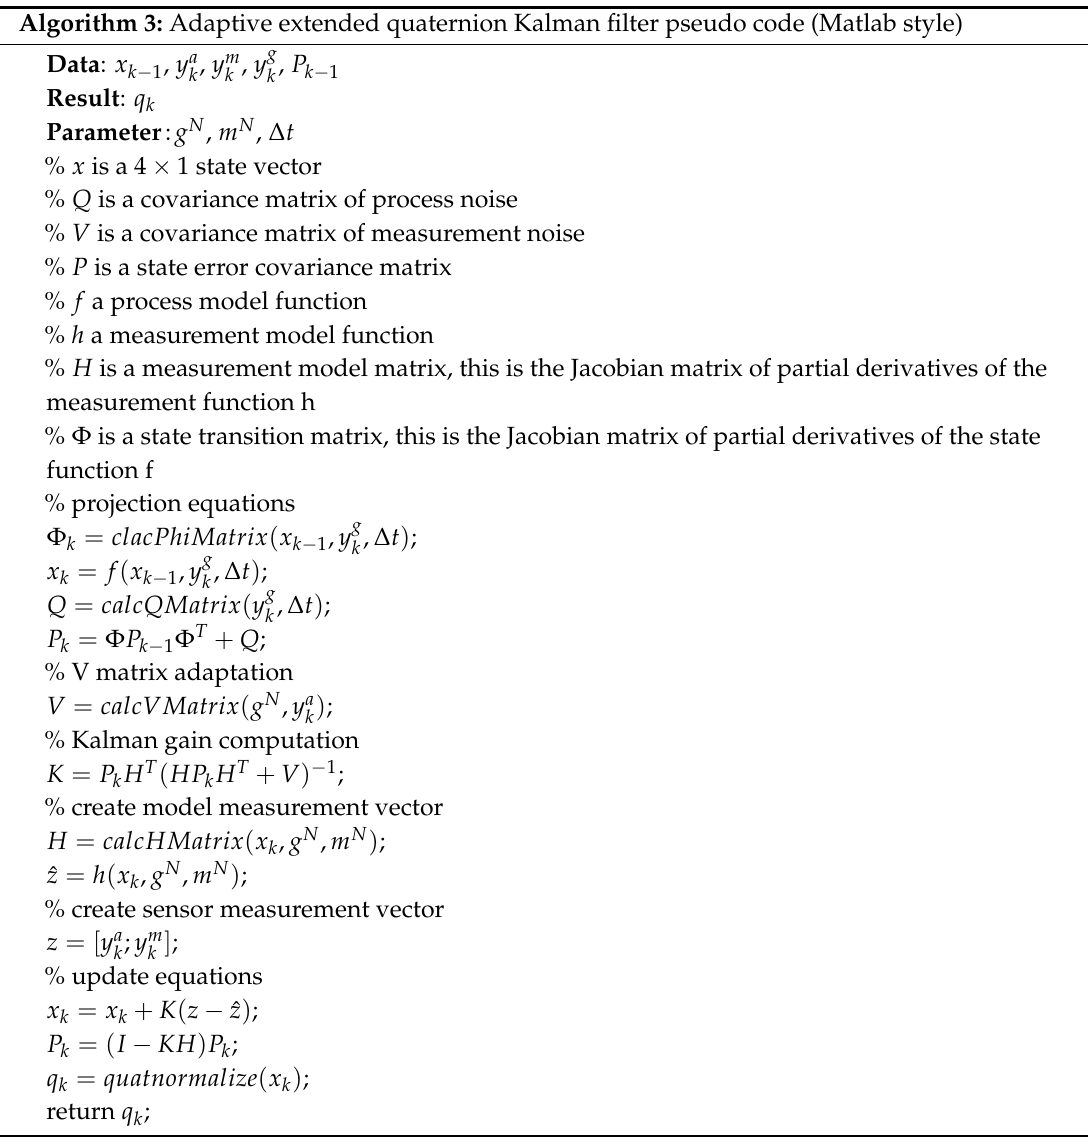
Algorithm 3: Adaptive extended quaternion Kalman filter pseudo code (Matlab